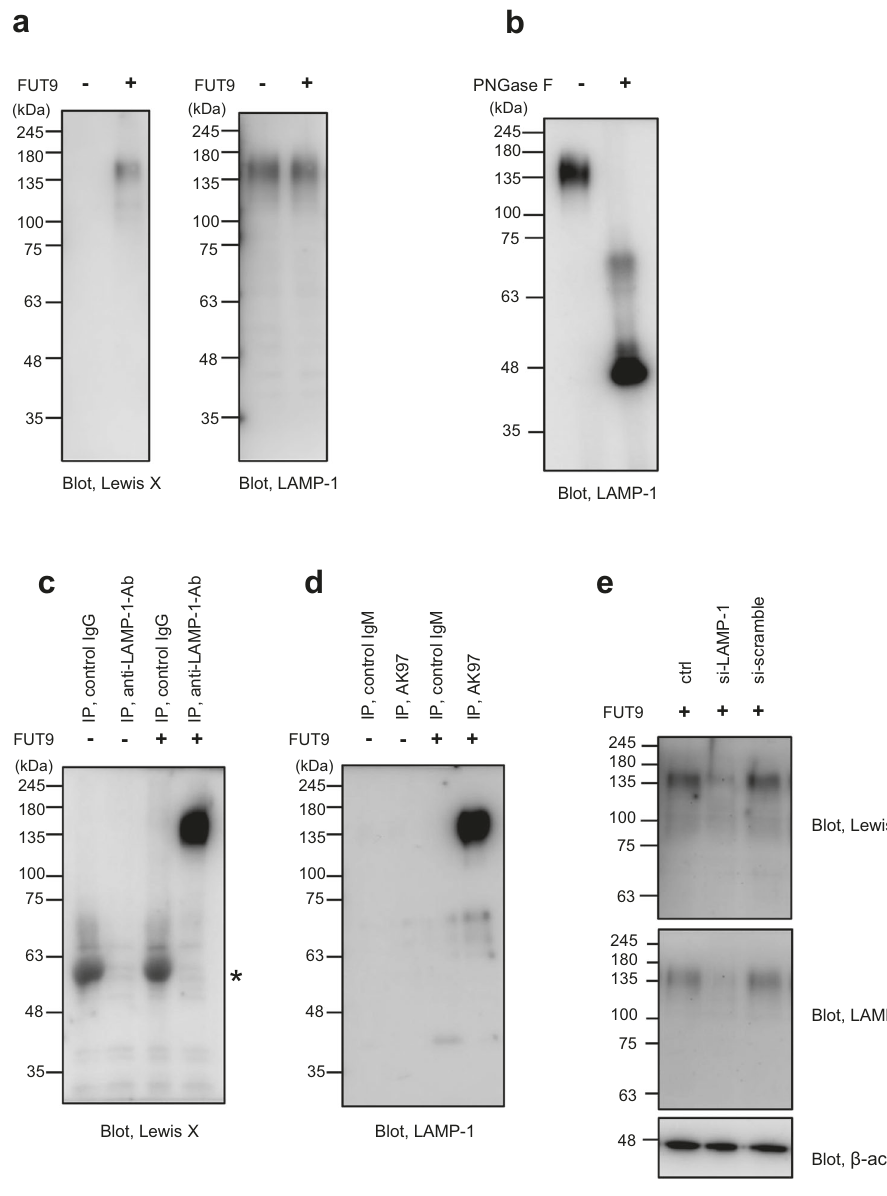
Fig. 1 FUT9-dependent Lewis X modi fi cation of LAMP-1 in CHO-K1 cells. a Immunoblot analysis of Lewis X modi fi cation (left) and LAMP-1 (right) in lysates from CHO-K1 cells transfected with or without FUT9 expression vector using the anti-Lewis X antibody, AK97, and anti-LAMP-1 antibody, respectively. b Immunoblot analysis of LAMP-1 in lysate of the CHO-K1 cells expressing FUT9 before and after PNGase F treatment. c Immunoblot analysis of Lewis X in cell lysates immunoprecipitated with anti-LAMP-1 antibody and control IgG (IP). The band indicated by asterisk corresponding to control IgG non-speci fi cally detected by the secondary anti-mouse IgM antibody. d Immunoblot analysis of LAMP-1 in cell lysates immunoprecipitated with anti-Lewis X and control IgM (IP). e Effects of knockdown of LAMP-1 on Lewis X modi fi cation in the CHO-K1 cells expressing FUT9. β -actin was used as a loading